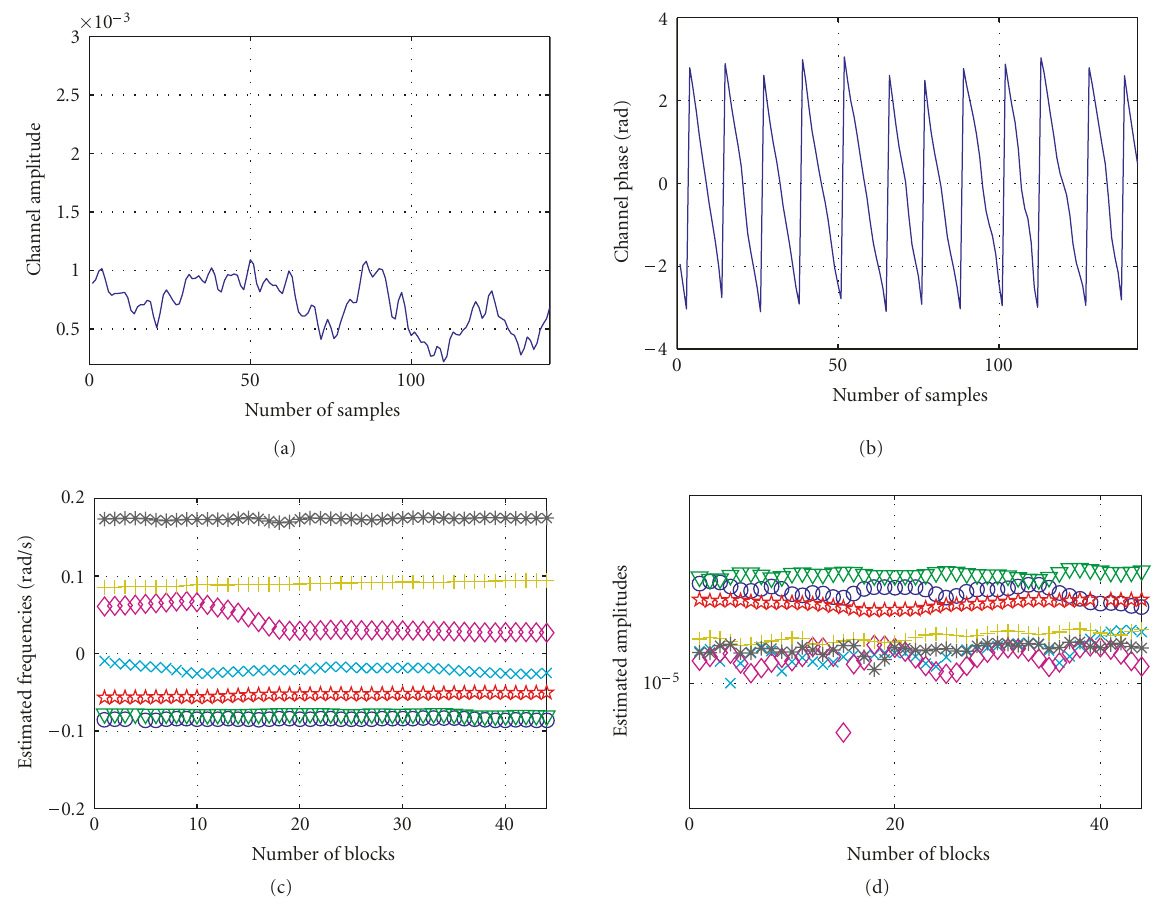
Figure 5: Example of the time variation of model parameters in a suburban area: (a) the channel amplitude, whose dynamic range is smaller than in Figure 4; (b) the phase of the channel, which is linear in the whole measurement interval; (c) the estimated frequencies of the sinusoids in each block, the number of sinusoids is assumed to be 7; (d) the amplitudes of the sinusoids associated to the frequencies in